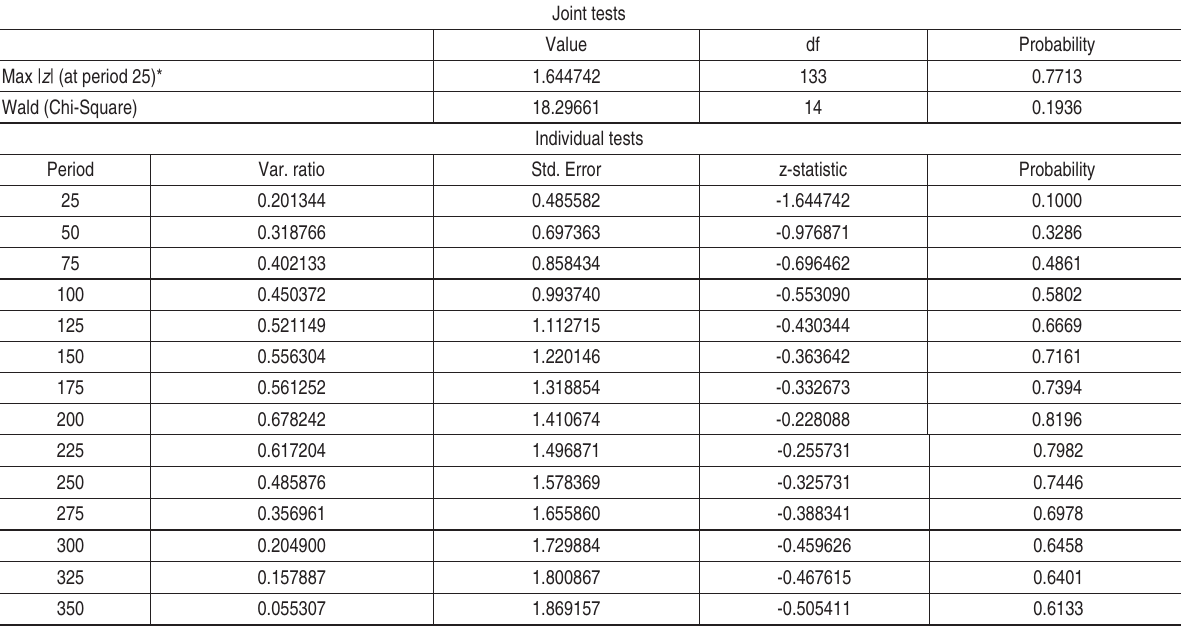
Table 6. Variance Ratio Test of the NSE ASI (weekly